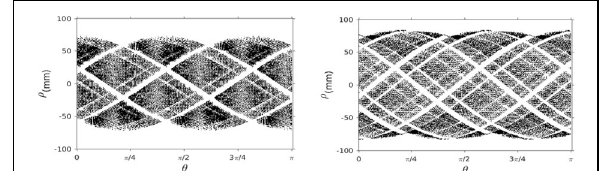
Fig. 2 (abstract A14). Sinograms of all possible combinations for two principal symmetries, the upper cap (left) and central section of the scanner (right). Slices correspond to heights z = 77mm and z = 22mm with respect to the center of the